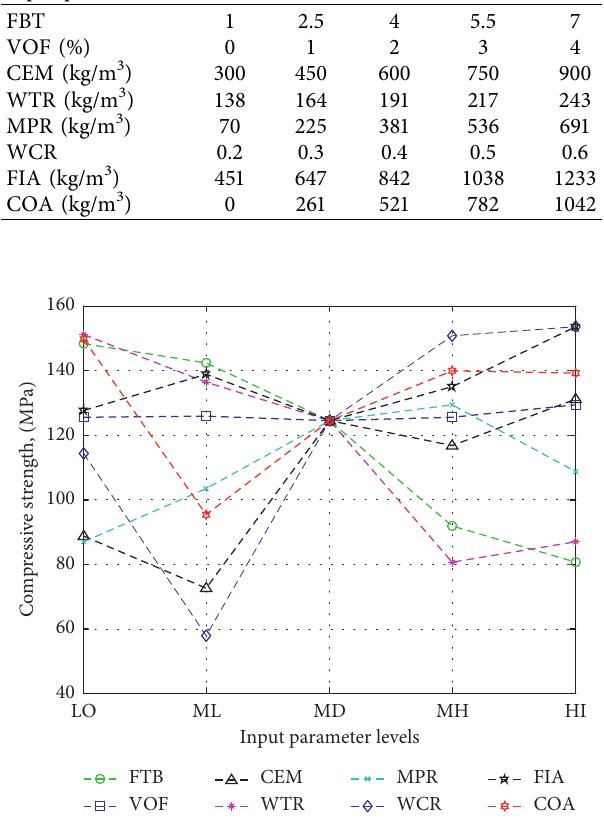
Table 8: Input parameter data for sensitivity analysis. Input parameters